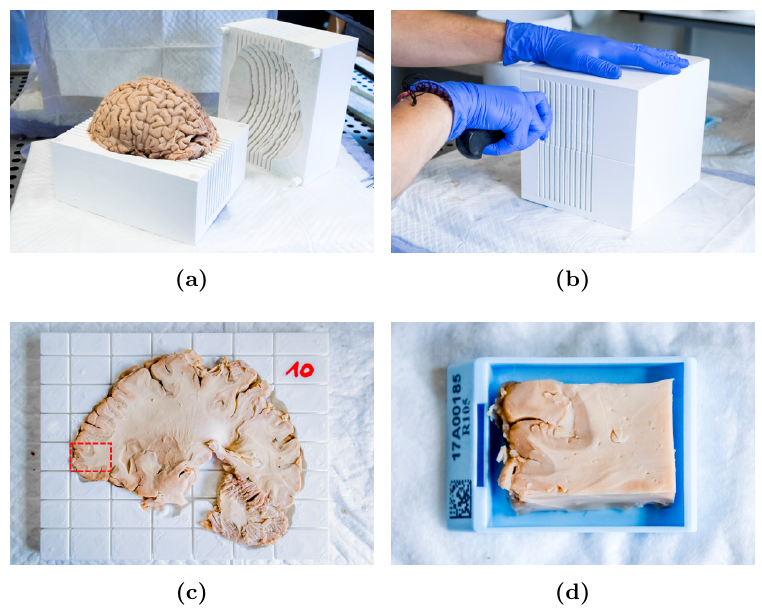
Figure 1. Brain slicing and sample collection procedure. ( a ) The brain is placed inside the 3D-printed slicer. ( b ) Sagittal slices are cut carefully. ( c ) Each brain slice is placed inside its cutting guide. ( d ) Sample blocks are cut with a scalpel along the grooves and placed into standard